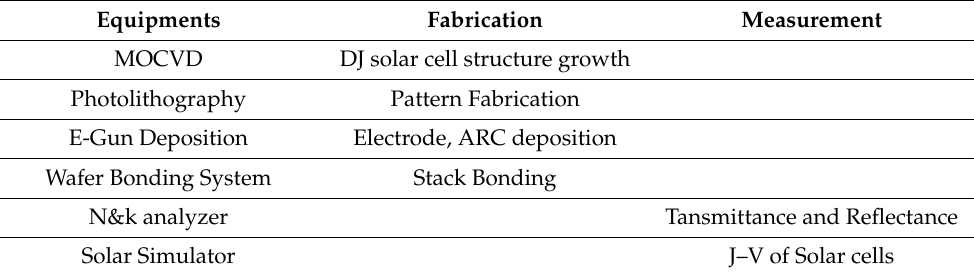
Table 1. All the key equipment used for measurement and fabrication methods in this study.